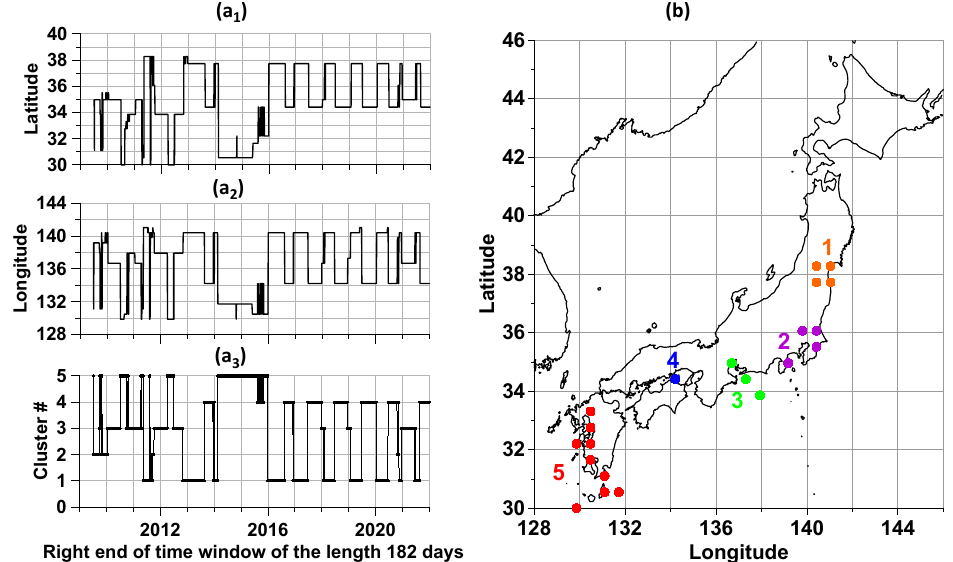
Figure 6. ( a 1 , a 2 ) are the latitudes and longitudes of the nodes of a regular grid of 30 × 30 in size, in which the maxima of the average weighted probability density of the distribution of extreme values of the properties of the tremor of the Earth’s surface were realized in sliding time windows 182 days long; ( a 3 ) are the corresponding numbers of clusters of maximum points. ( b )—division of points of the trajectory of maxima into five clusters.